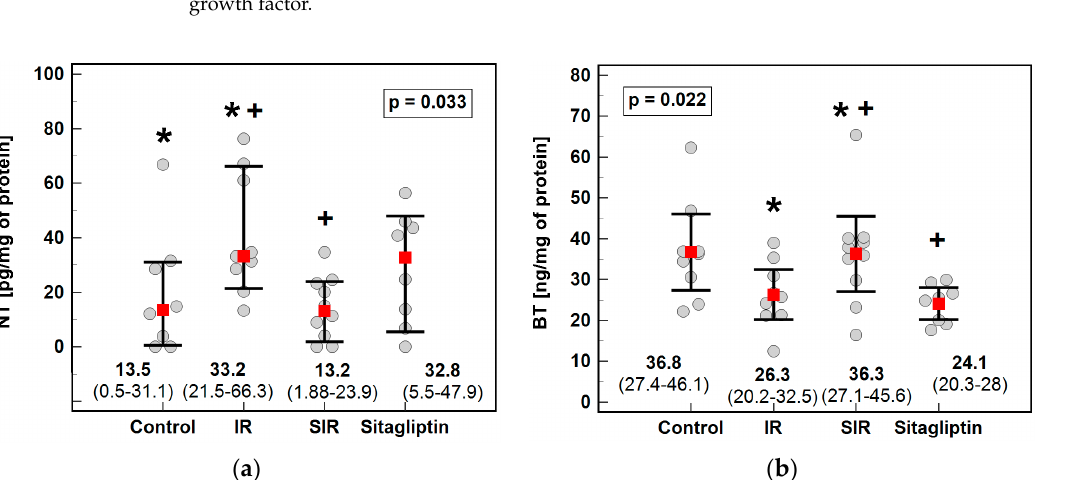
Figure 4. Effect of ischemia/reperfusion injury and sitagliptin on hepatic concentration of ( a ) 3-nitrotyrosine (NT); ( b ) 3-bromotyrosine (BT). Data are presented as medians or means with 95% confidence interval (CI) and analyzed with Kruskal–Wallis H test or one-way ANOVA for, respectively, NT and BT. Significant ( p < 0.05) between-group differences are marked by the same type of symbols: *, +. IR, ischemia/reperfusion group; SIR, ischemia/reperfusion group pretreated with sitagliptin.